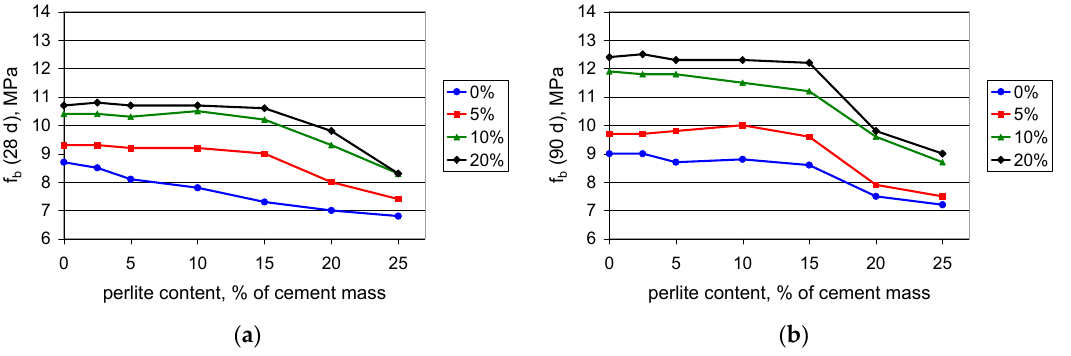
Figure 4. Flexural strength of mortars with polymer content values of 0%, 5%, 10%, and 20% of cement mass vs. waste perlite content: ( a ) after 28 days; ( b ) after 90 days of curing.